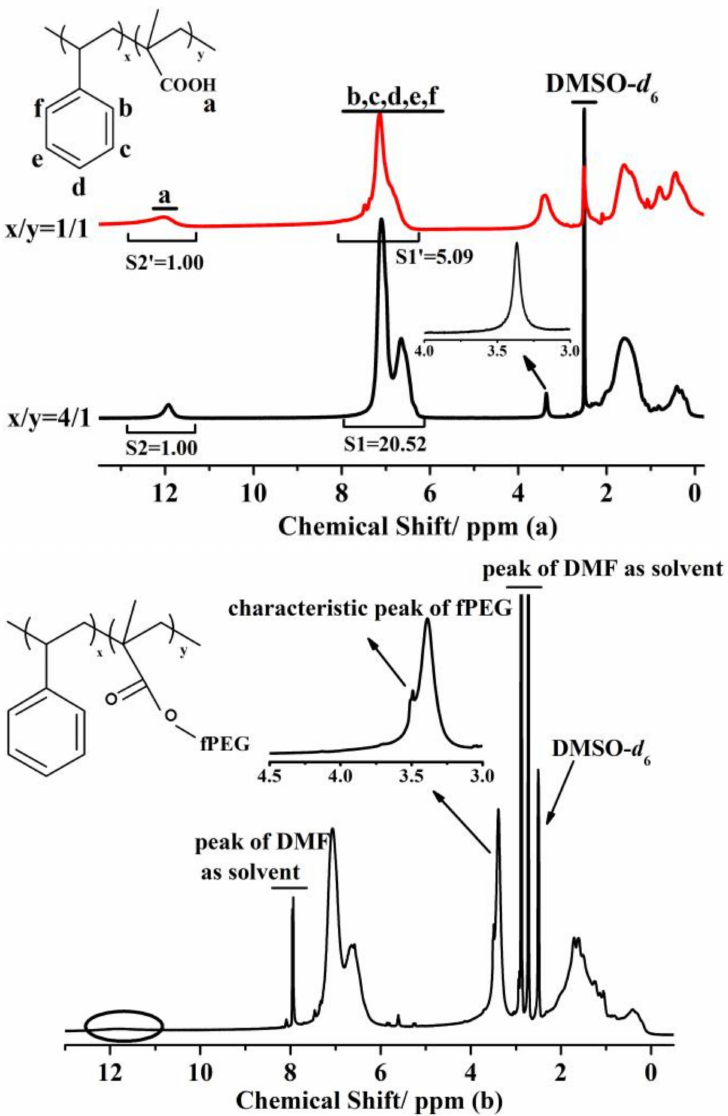
Figure 1. Typical 1 H NMR spectra of the copolymers of ( a ) P(St x - co -MAA y ) (with x:y = 4:1 and 1:1), and ( b ) P(St x - co -MAA y )- g -fPEG y (with x:y =